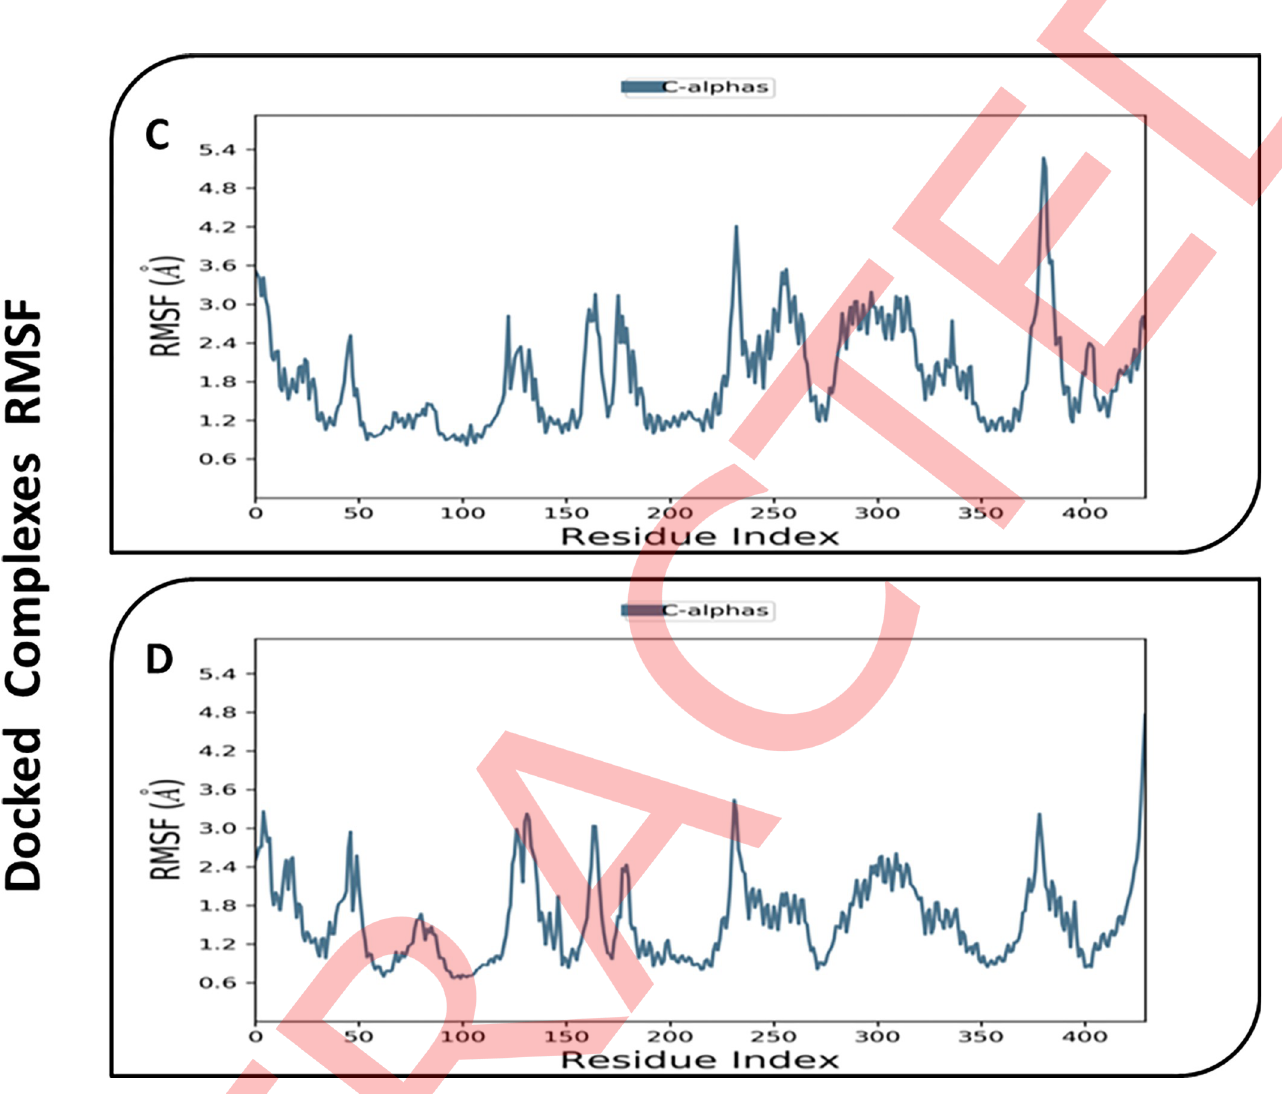
Fig 6. Root mean square fluctuation of docked complexes plots over